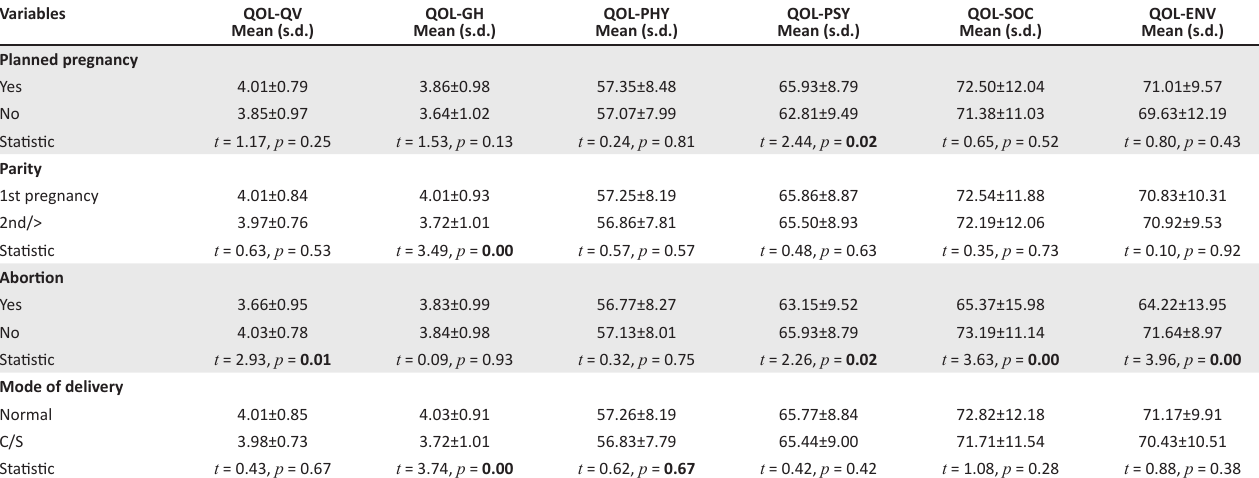
TABLE 8: Relationship between quality of life and obstetric/gynaecological characteristics (both trimester).